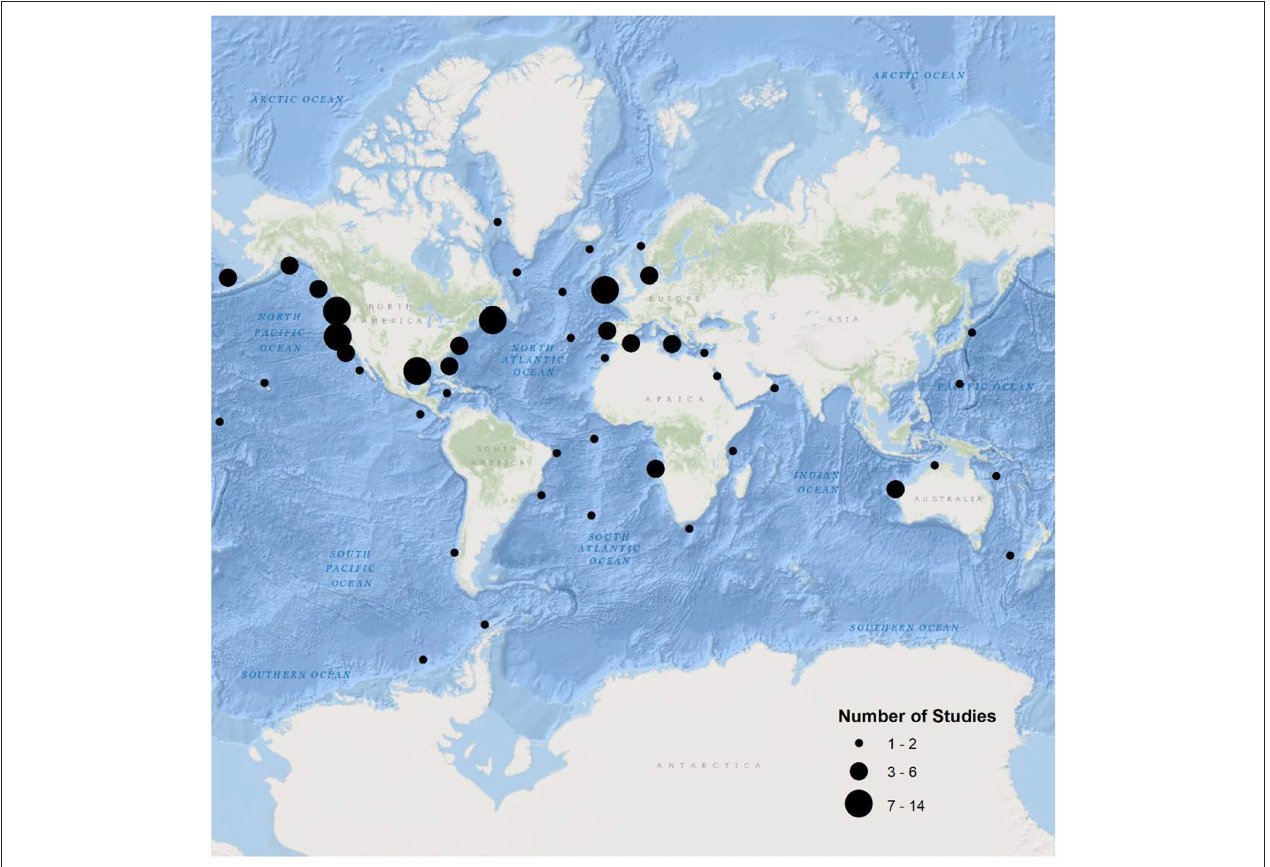
FIGURE 5 | The location of studies using ROV surveys to visually assess fish assemblages identified using the keywords “remotely operated vehicle*,” “ROV or ROV’s,” and “fish or fishes” in the search engines Scopus TM and Google Scholar TM